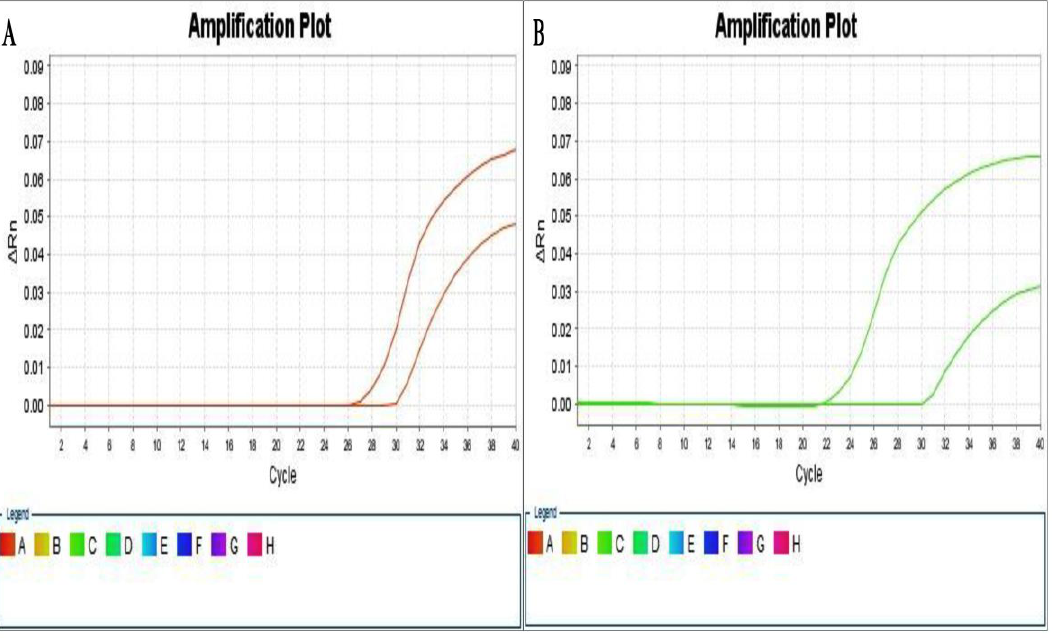
Figure 1. (A) This figure shows ERG-11gene expression in correlation with ACT1 gene expression in sensitive isolate. (B) This figure shows ERG11gene expression in correlation with ACT1 gene expression in esistant